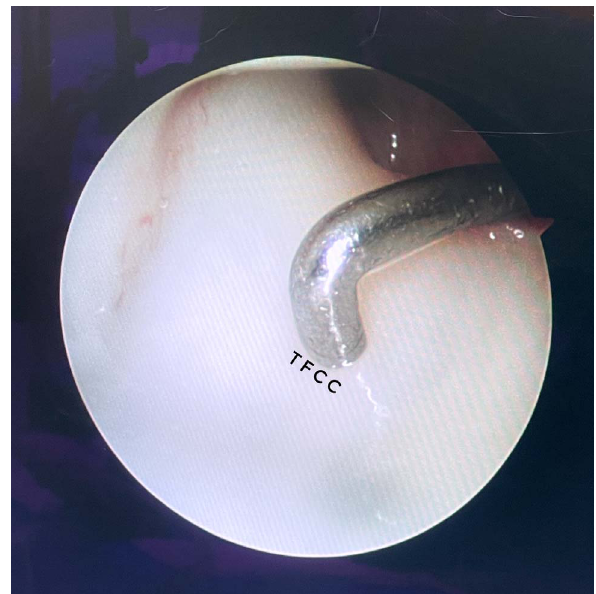
Figure 4. Arthroscopy visualization of the TFCC allows direct and magni fi ed visualization of the anatomical area, which provides the surgeon a more thorough understanding of the injury compared to an open procedure. TFCC, Triangular Fibrocartilaginous